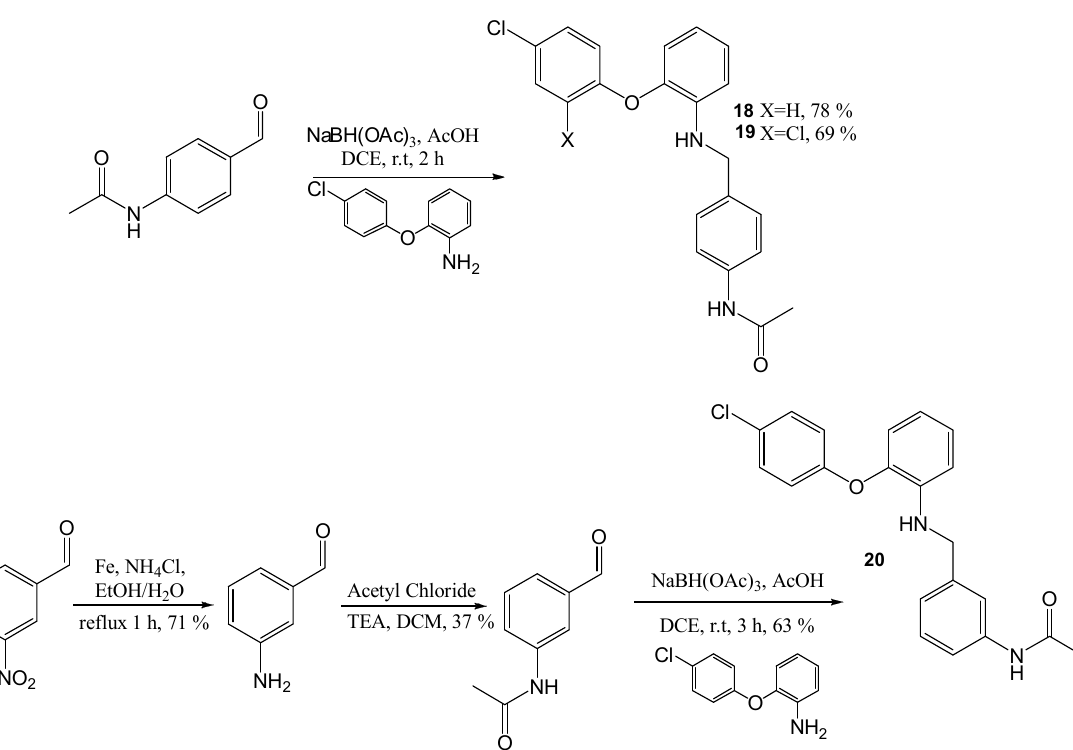
Table 3. Biological data for compounds with a migrated N -acetamide group; a results obtained from the TLC assay. Mean of at least two measurements with typically an SD of ±5%. Cl